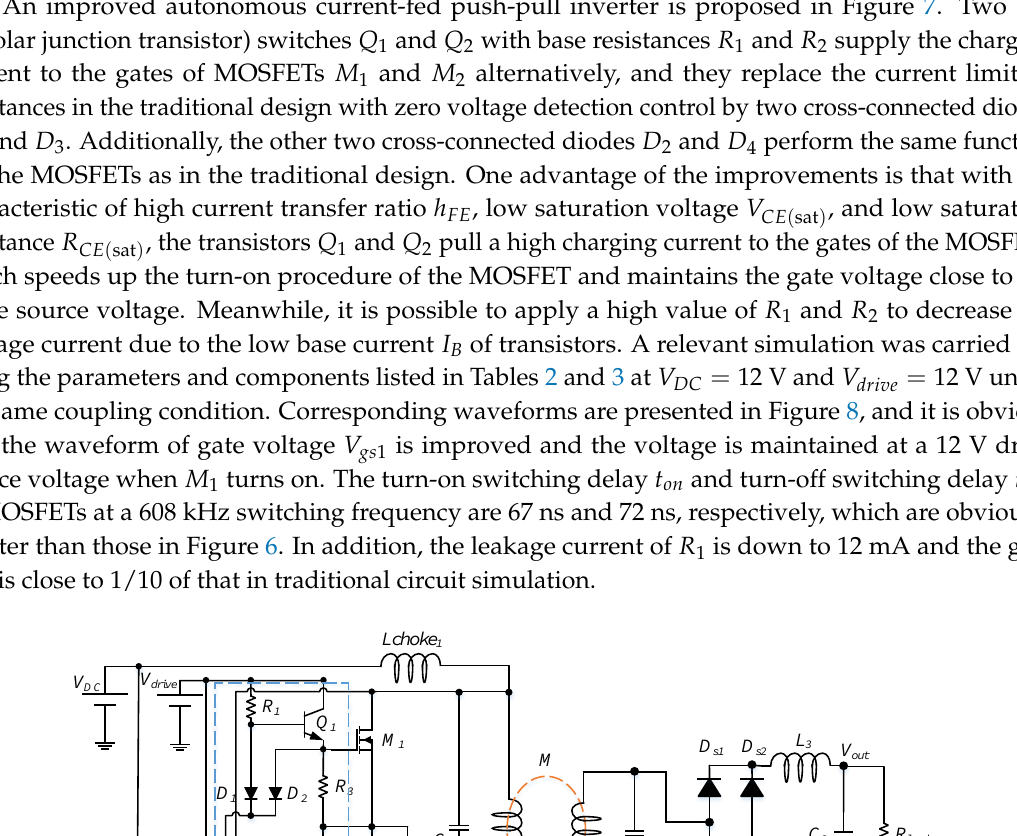
t off Figure 8. Voltage and current waveforms of the improved circuit simulation at V DC = 12 V. Another advantage of the proposed inverter is the separation between the DC voltage source DC V